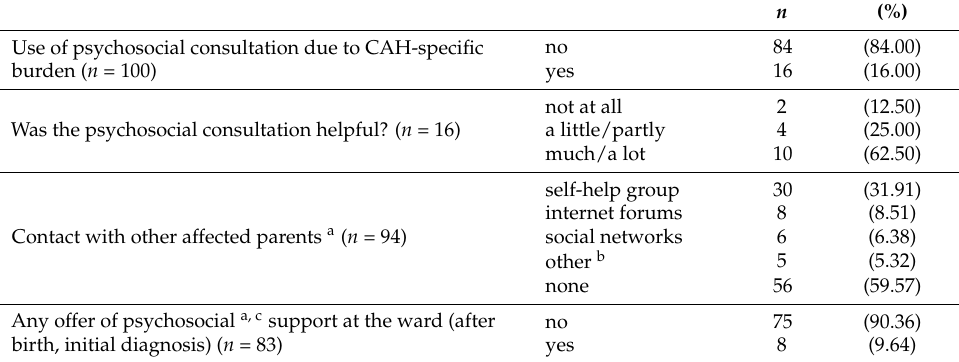
Table 3. Use of psychosocial